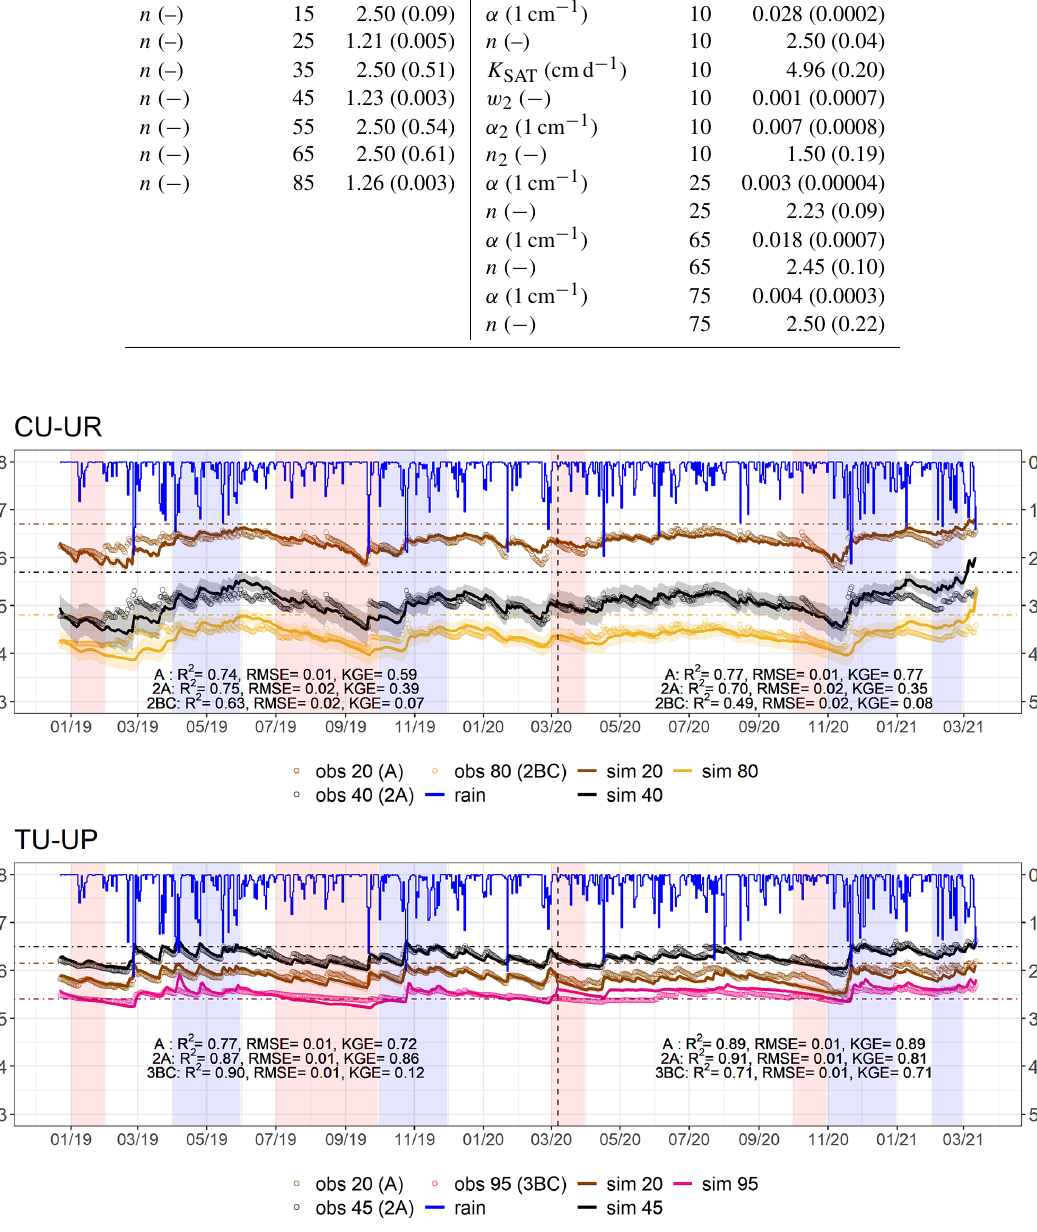
Figure 4. Simulated (thin line) and observed (dots) volumetric water content (VWC) for (a) the CU-UR profile and (b) the TU-UP profile. The rainfall is represented by the blue line. Brown and black colors represent the A (at 20cm) and 2A (at 40 / 45cm) horizons for both soil profiles. The yellow and pink lines represent the 2BC (at 80cm) and 3BC (at 95cm) horizons for the CU-UR and TU-UP profiles, respectively. The vertical dashed line separates the calibration and validation periods. Horizontal dot-dashed lines indicate field capacity ( θ FC = − 10kPa) at the corresponding depth. Red stripes represent months defined as dry periods, while blue stripes represent months defined as wet periods. The colored bands around the simulated VWC show the 95% confidence